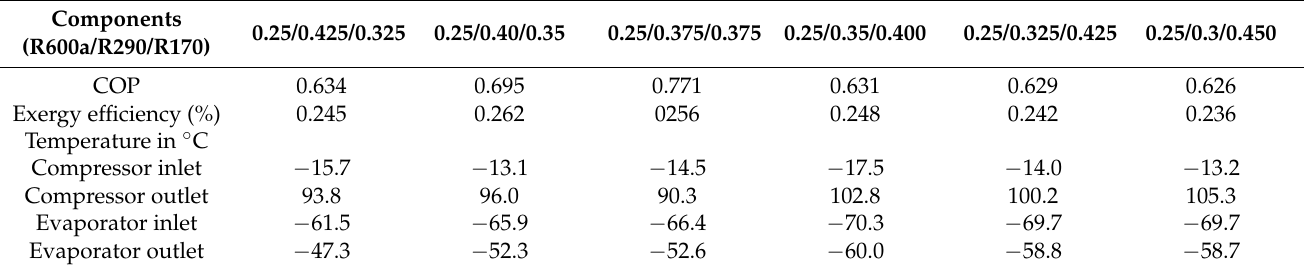
Table 2. The performance comparisons between different initial components.